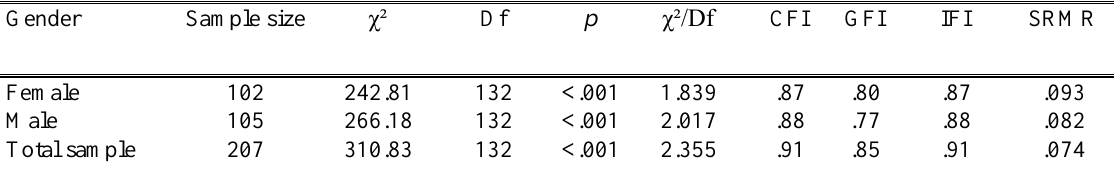
Results from confirmatory factor analysis by gender and total sample